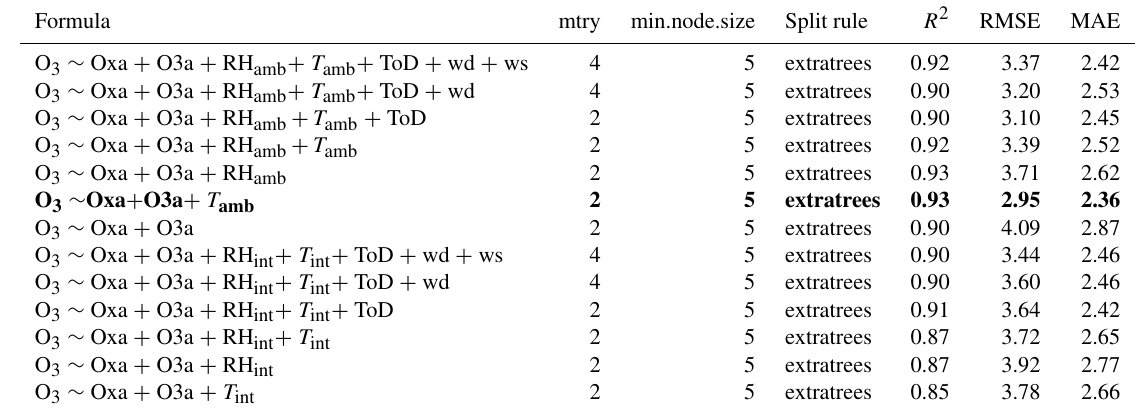
Table 5. Results of the RF model selection process for O 3 . Min.node.size and split rule were optimized in a previous step not shown here for brevity and are therefore constant. The most accurate model is in bold. RMSE and MAE are in units of parts per billion. Formula